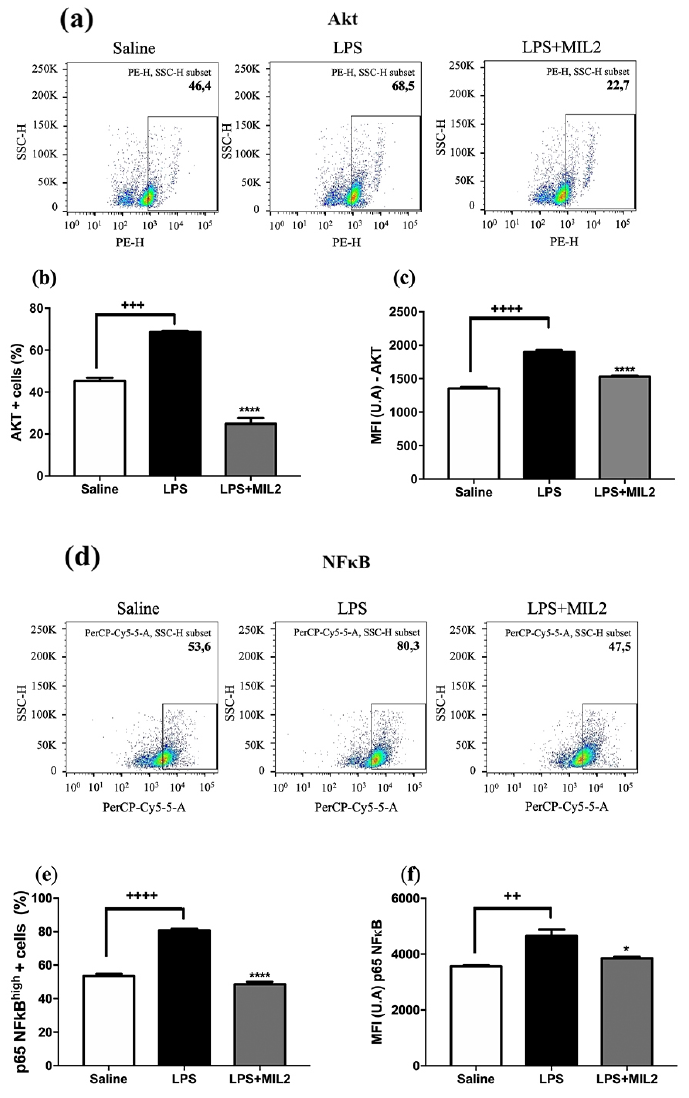
An Acad Bras Cienc (2022) 94(Suppl. 4) e20211327 8 | 13